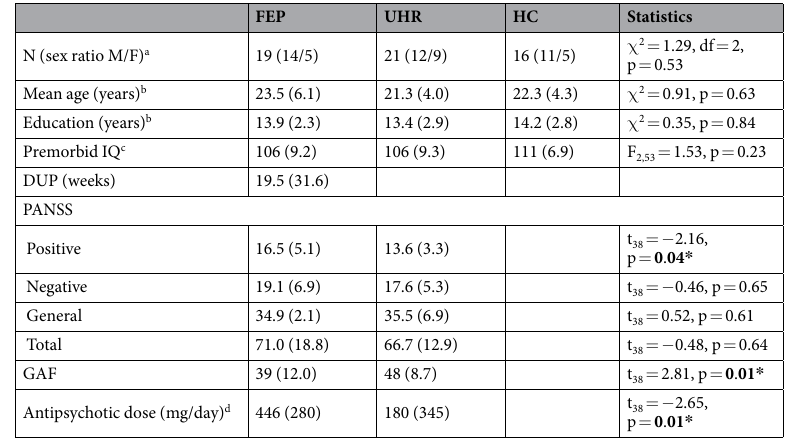
Table 1. Demographic characteristics of study participants. All values are shown as mean (standard deviation). Significant group differences are shown to the right. a Chi-square test, b Kruskal-Wallis test, c one-way ANOVA. Otherwise, t-tests were used. P < 0.05 was considered significant. d Chlorpromazine equivalent dose. Calculation for the mean antipsychotic dose include all patients including unmedicated ones. Abbreviations: FEP, first- episode psychosis; UHR, ultra-high risk; HC, healthy controls; IQ, intelligence quotient; PANSS, positive and negative symptom scale; GAF, global assessment of functioning; DUP, duration of untreated